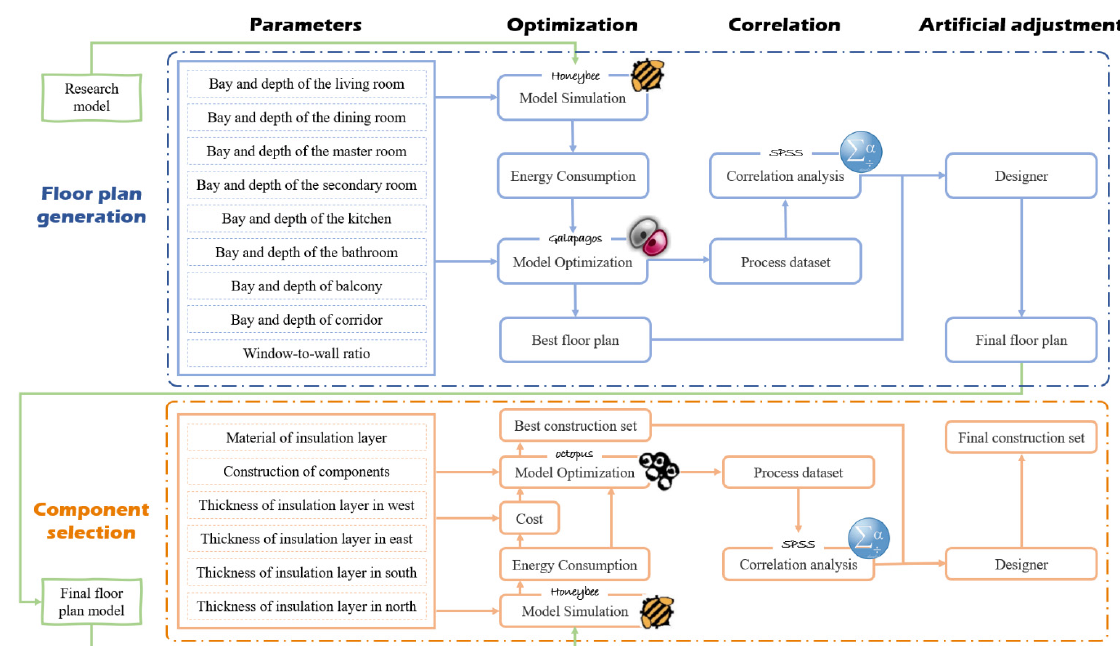
Figure 1. Optimized design workflow based on floor plan generation and component selection.